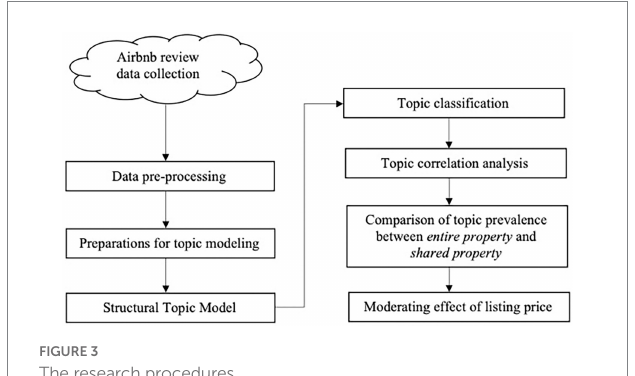
FIGURE 3 The research